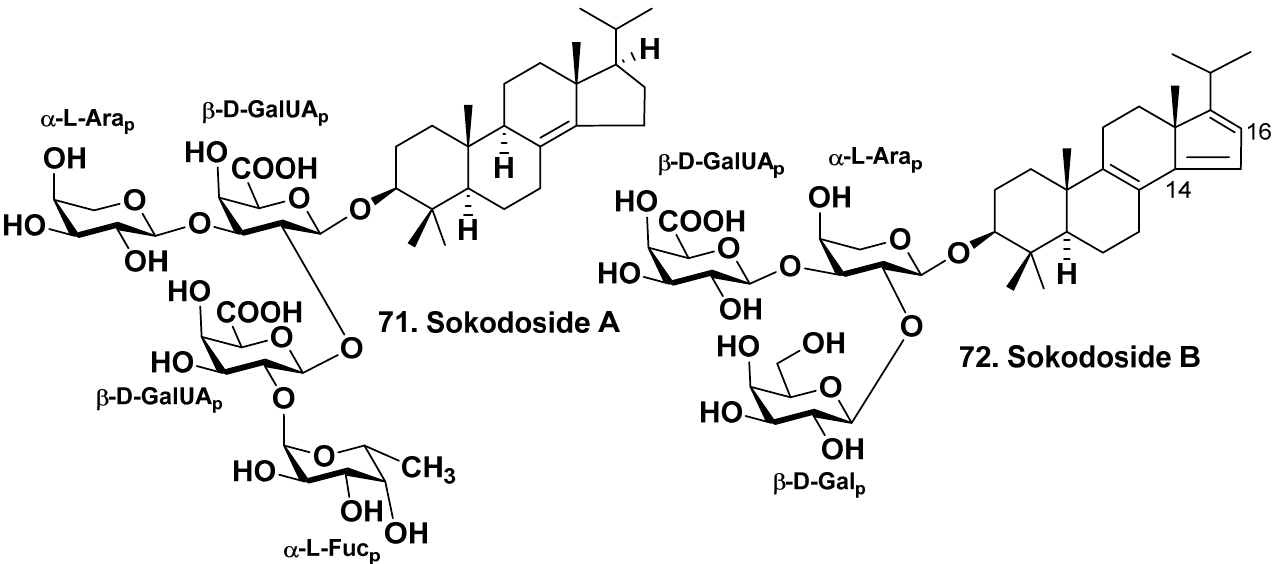
Figure 6. Sokodosides A ( 71 ) and B ( 72 ) from Erylus placenta .